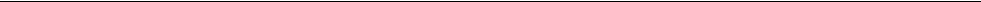
Fig. 5 RTTN directly interacts with and acts downstream of STIL. a Schematic representations of full-length RTTN-FL (1 – 2226), RTTN-N (1 – 889), RTTN-M (748 – 1510) and RTTN-C (1343 – 2226). b Mapping the STIL-interacting domain in RTTN. HEK293T cells were co-transfected with GFP-STIL and various Flag-tagged RTTN constructs, and then analyzed by immunoprecipitation (IP) and subsequent immunoblotting (IB) using the indicated antibodies. c GST-pulldown assay. GST and GST-RTTN-N (1 – 889) recombinant proteins were af fi nity puri fi ed and used to pulldown the indicated proteins from lysates of HEK293T cells that had been transfected with various Flag-STIL constructs. d Yeast two-hybrid assay shows a direct interaction between truncated STIL (1 – 628, prey) and various portions of RTTN (bait). The positive interaction between STIL and RTTN was demonstrated by the growth of mating colonies on QDO plates. e Endogenous RTTN and GFP-STIL form a complex in vivo. HEK293T cells were transfected with GFP-STIL. Twenty-four hours after transfection, the cell lysates were immunoprecipitated with anti-RTTN antibodies and immunoblotted with anti-STIL and anti-RTTN antibodies. f Mapping the centrosome-targeting region of RTTN. U2OS cells were transiently transfected with various GFP-tagged truncated RTTN